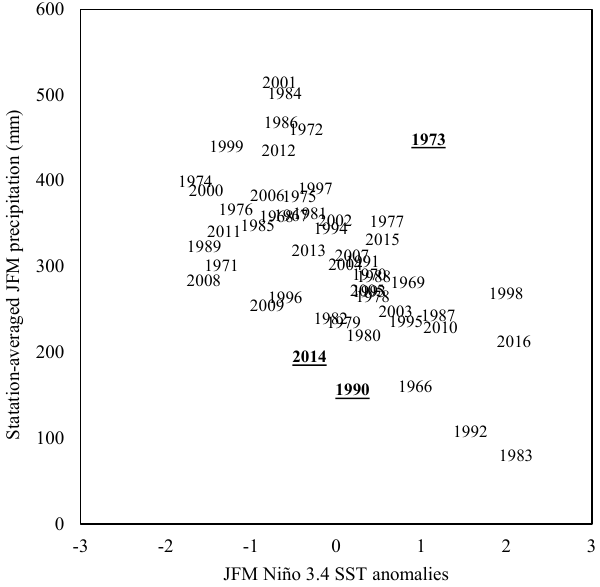
Figure 6. Three outlier years in which general relationship between Niño 3.4 and regional precipitation did not hold to be true are bolded and underlined. If the three outlier years (1973, 1990, and 2014) are removed, the relationship between precipitation and SST anomalies strengthens ( r =− 0.66, p value =